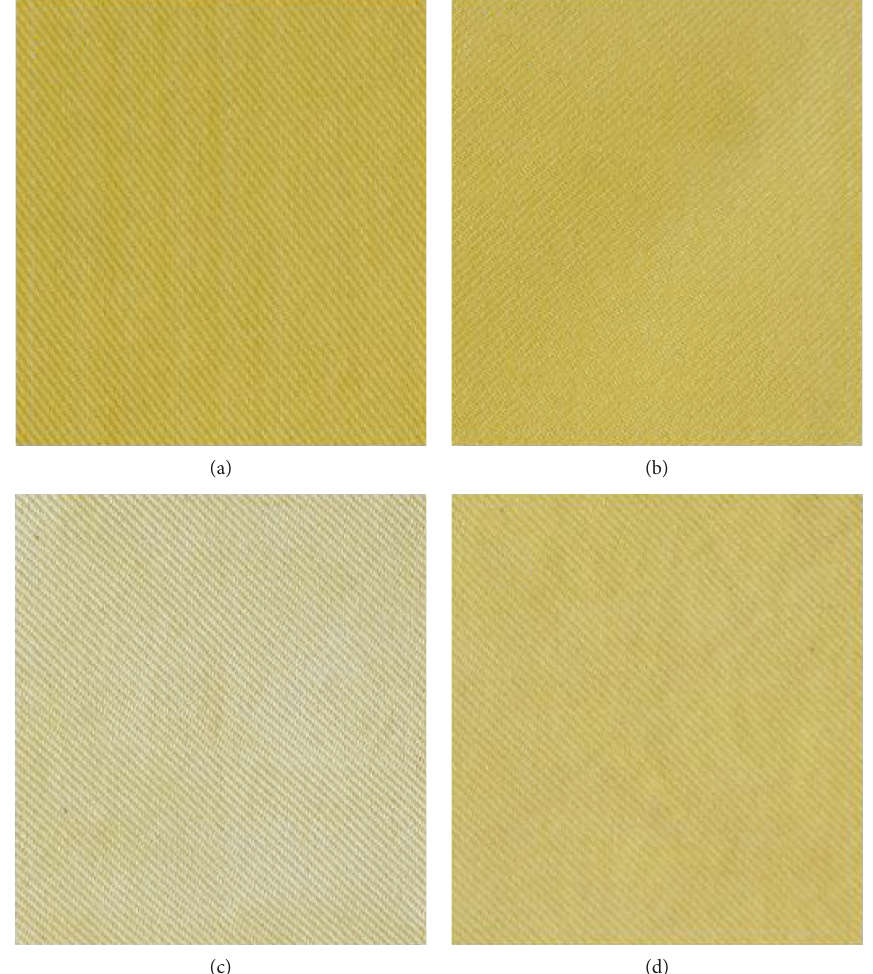
Figure 5: Picture of cross-linked and uncross-linked NCS fabrics before and after washing for 20